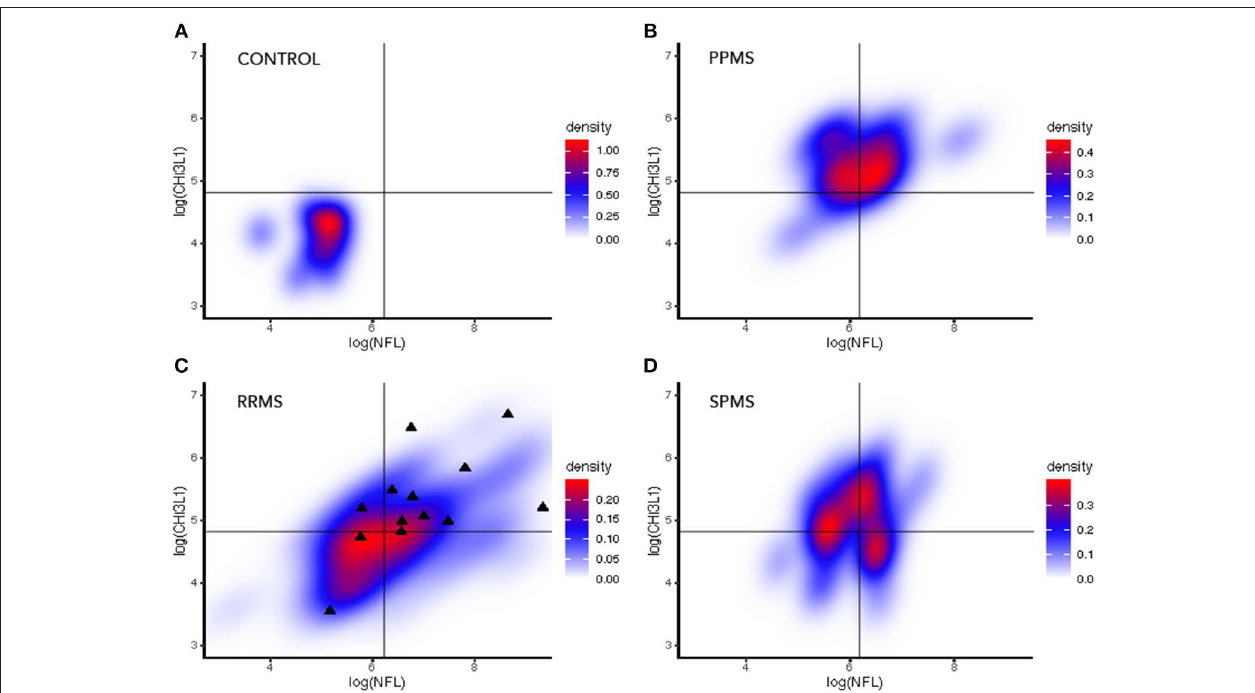
FIGURE 4 | Density maps representing paired NFL and CHI3L1 values in CSF of non-MS controls and MS patients. The black lines in each diagram represent the median log values of CSF NFL and CHI3L1 in the whole cohort. Note that each subgroup has the peak density of patients in a different position in reference with the median log values. (A) In non-MS control group, almost all patients fell in the left-inferior quadrant. (B) In PPMS subgroup, CHI3L1 levels were over the median in almost all patients, and two groups were distinguished with regards to NFL levels. (C) In the RRMS group, black triangles represented patients that at the end of the observation period evolved to progressive disease. (D) SPMS patients constitute an intermediate density map with three regions of distribution. NFL, neurofilament light chain; CHI3L1, chitinase-3-like-1; RRMS, relapsing-remitting multiple sclerosis; SPMS, secondary progressive multiple sclerosis; PPMS, primary progressive multiple sclerosis; Switch, diagnosis of SPMS during follow-up.